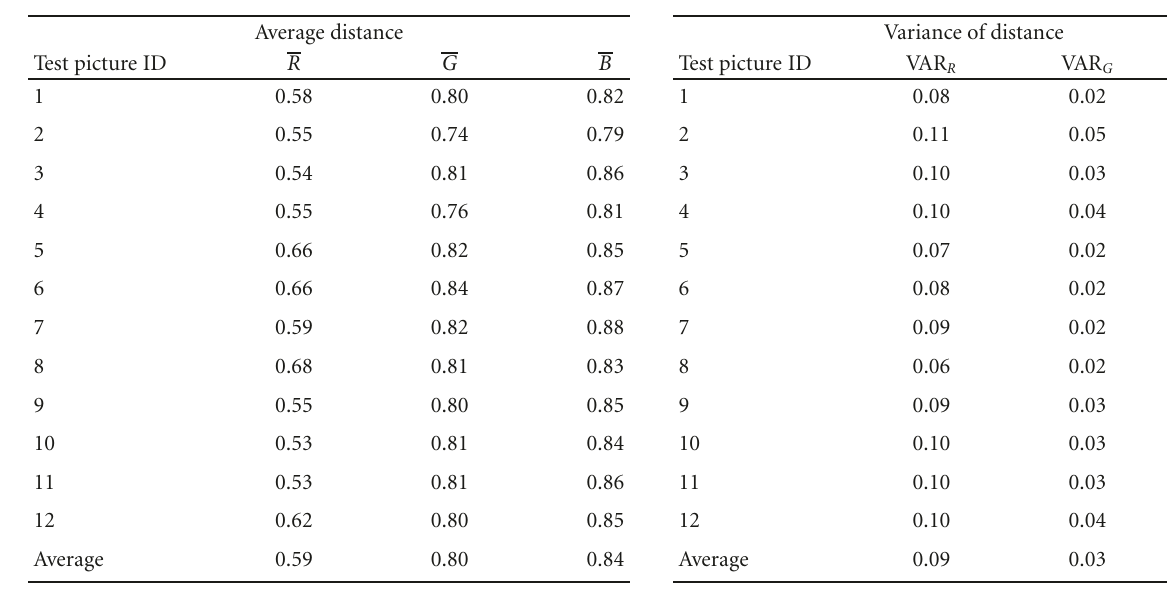
Table 2: The analysis of